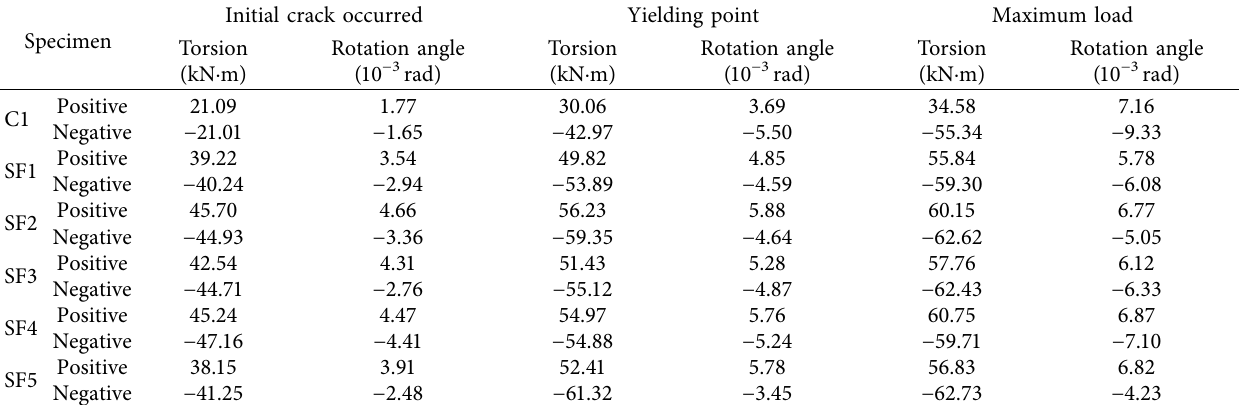
Figure 14: Damage and hysteresis curves of specimen SF5. Table 7: Torsion and rotation angle at the critical loading